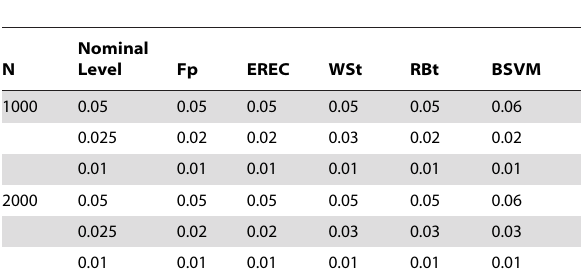
Table 2. Type I error for the five approaches.